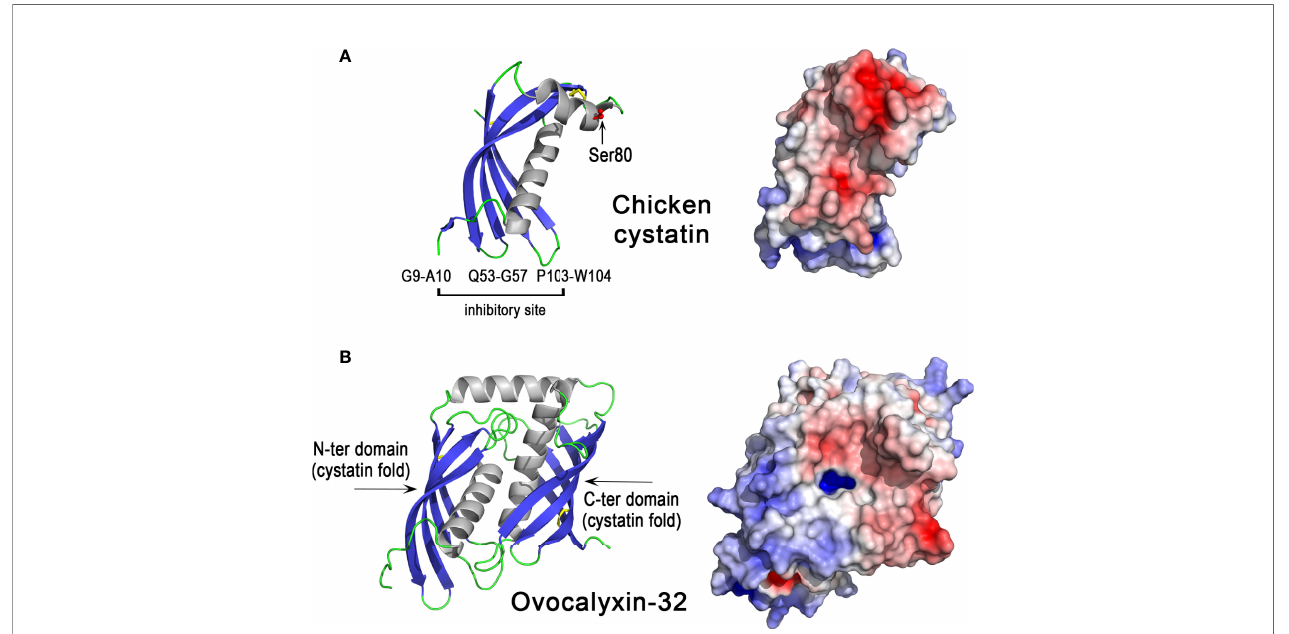
FIGURE 6 | 3D structures of egg antiproteases with cystatin fold, chicken cystatin and ovocalyxin-32. 3D structure of chicken cystatin (A) and chicken ovocalyxin-32 (B). The left panels correspond to the cartoon representation of 3D structure while the right panels show the color-coded electrostatic potential molecular surface. Color scheme ranges from red (negatively charged regions) to deep blue (positively charged regions). The fi gure was prepared using Pymol software (48) and APBS (Adaptive Poisson-Boltzmann Solver) plugin (49) for electrostatic calculations using X-ray atomic coordinates of 1CEW PDB fi le for chicken cystatin. The 3D structure of OCX-32 was modeled using the AlphaFold method and was retrieved in the AlphaFold protein structure database under accession number AF-Q90YI1-F1 (72,